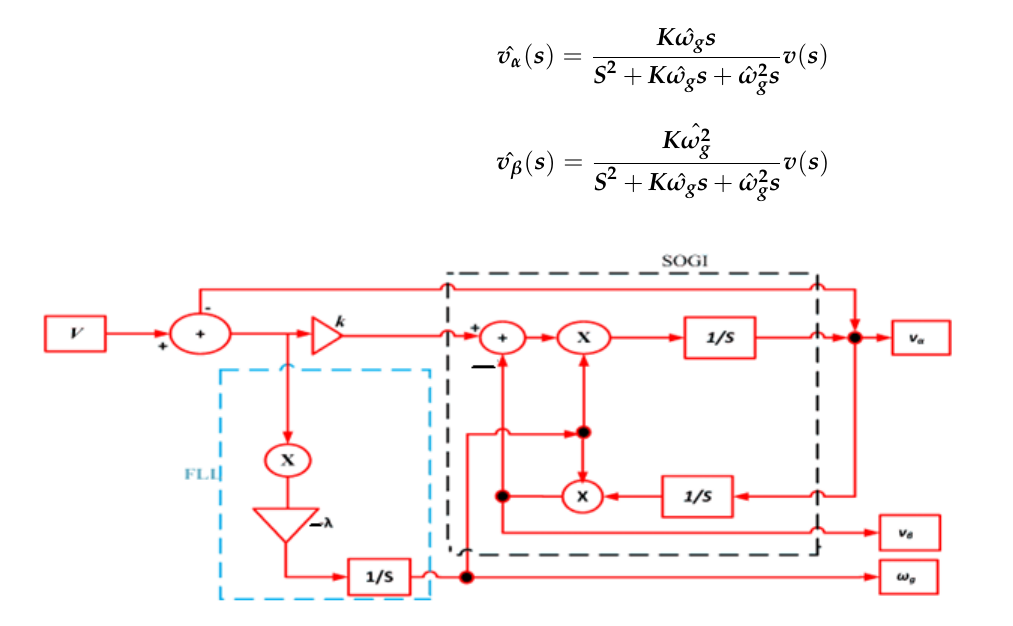
Figure 10. Block diagram of standard SOGI-FLL. Figures 11 and 12 show the frequency response of ˆ v α ( s ) and ˆ v β ( s ) for different values of k, respectively.